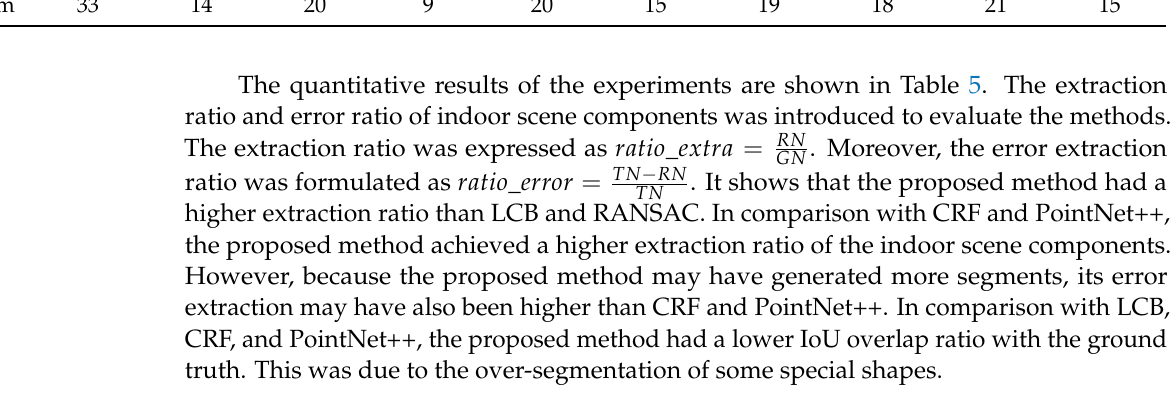
Table 5. The extraction ratio of indoor scene components and topological